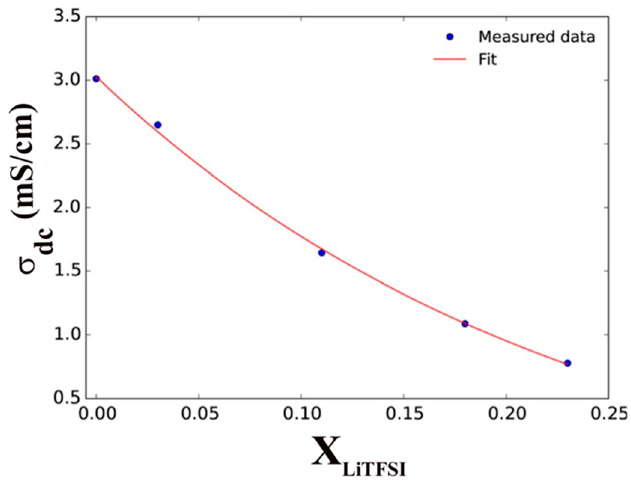
Figure 6. Variation of the ionic conductivities of different solutions of electrolytes with mole fraction of LiTFSI (X LiTFSI ) in Pyr 14 TFSI, copyright; Reprinted with permission from Ref. [91]. Copyright 2015 Wiley-VCH Verlag GmbH. Reproduced with permission.